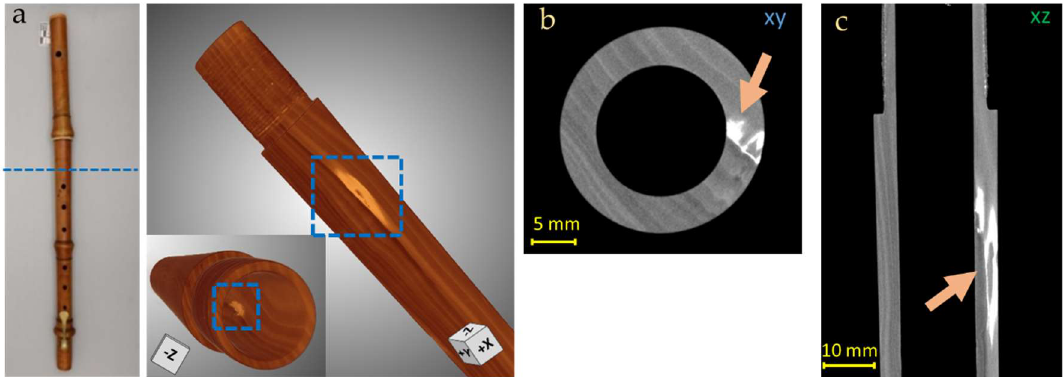
Figure 11. Original and 3D render ( a ) and CT horizontal ( b ) and vertical ( c ) slices of the Transverse Flute body (left hand), in which area of higher density was observed (orange arrows), also visible in the 3D model (blue squares). Blue line in the original pictures indicates the high of descripted fea- ture.